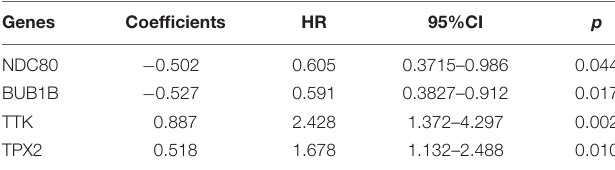
TABLE 3 | Multivariant analysis of hub